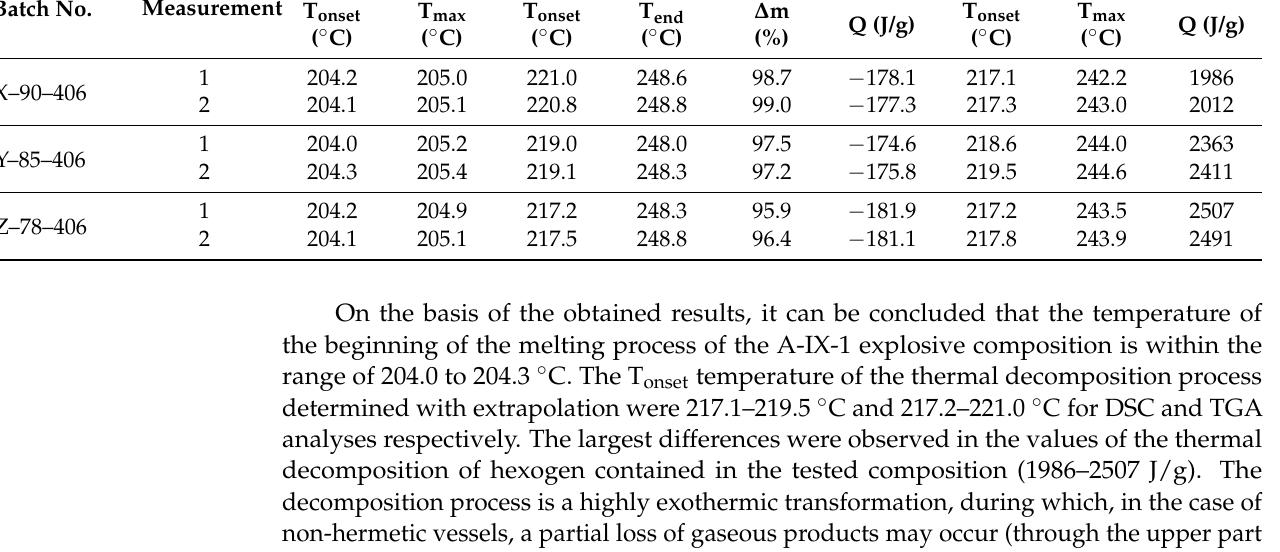
Figure 8. DSC ( a ) and TGA ( b ) curves obtained for samples of A-IX-1 material extracted from PG-7 warheads. Table 6. Values of parameters obtained during DSC and TGA analyses for samples of A-IX-1 material extracted from PG-7VM warheads. Batch